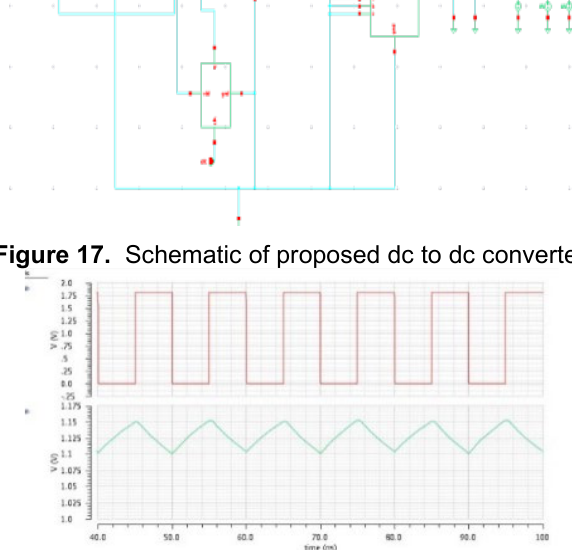
Figure 18. Output waveform of proposed dc to dc